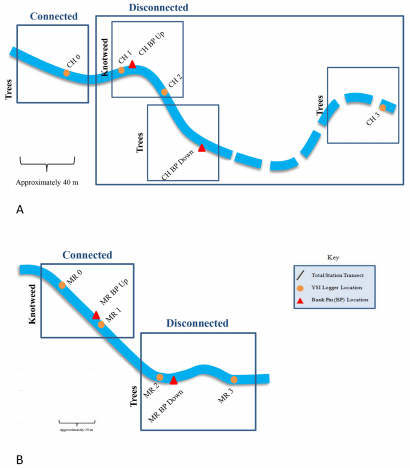
Figure 2. Sketch map of study reaches at Chelten Hills ( A ) and Mill Run ( B ) showing the locations and descriptions of each reach. Solid lines are drawn approximately to scale, dashed line indicate change in mapped distance. Stream flow is from station 0 to 3. Bank incision and riparian cover defined by boxed